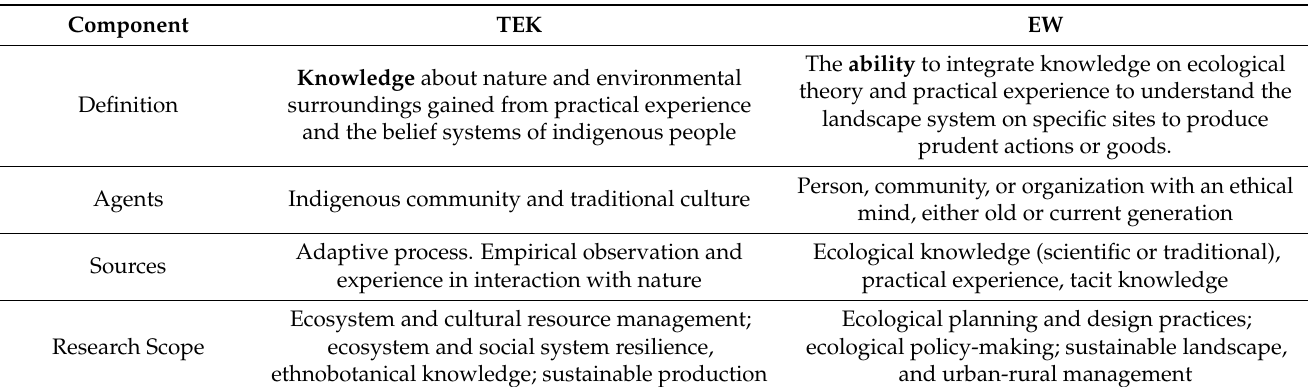
Table 3. The comparison analysis of TEK and